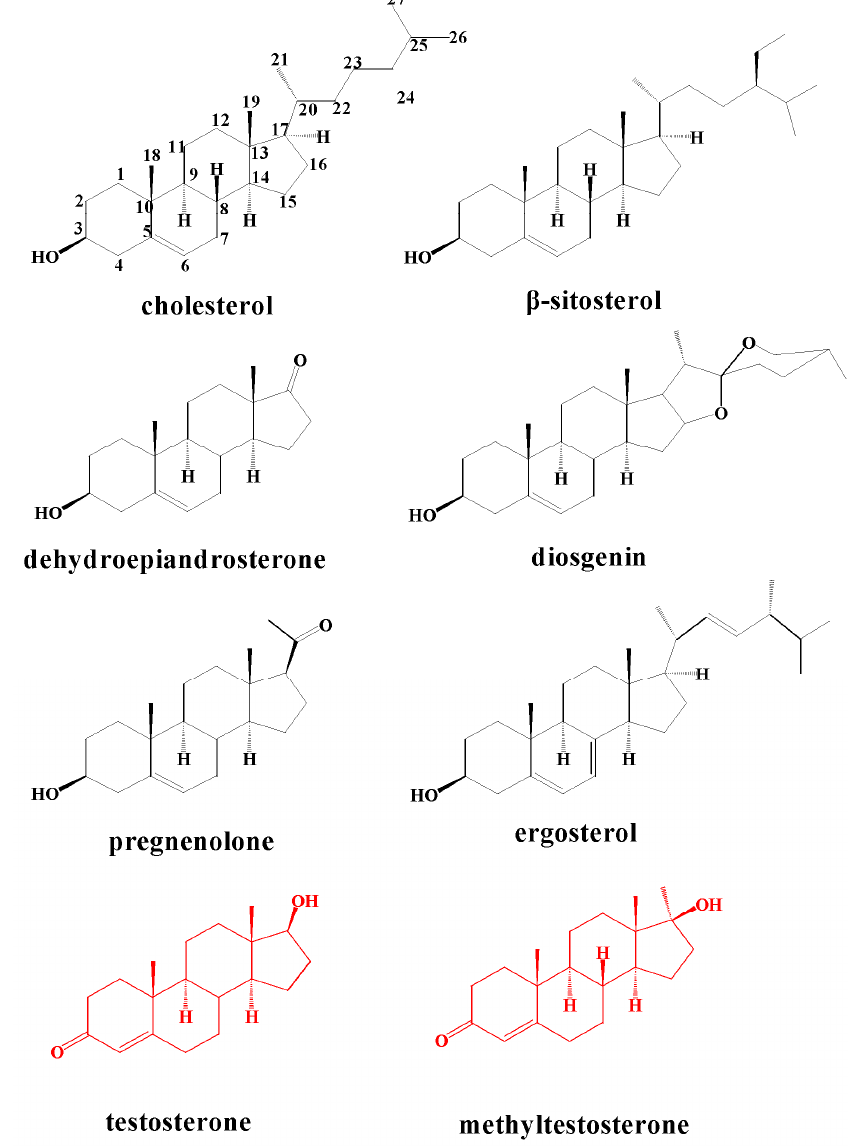
Figure 2. Chemical structures of the compounds used in this study.